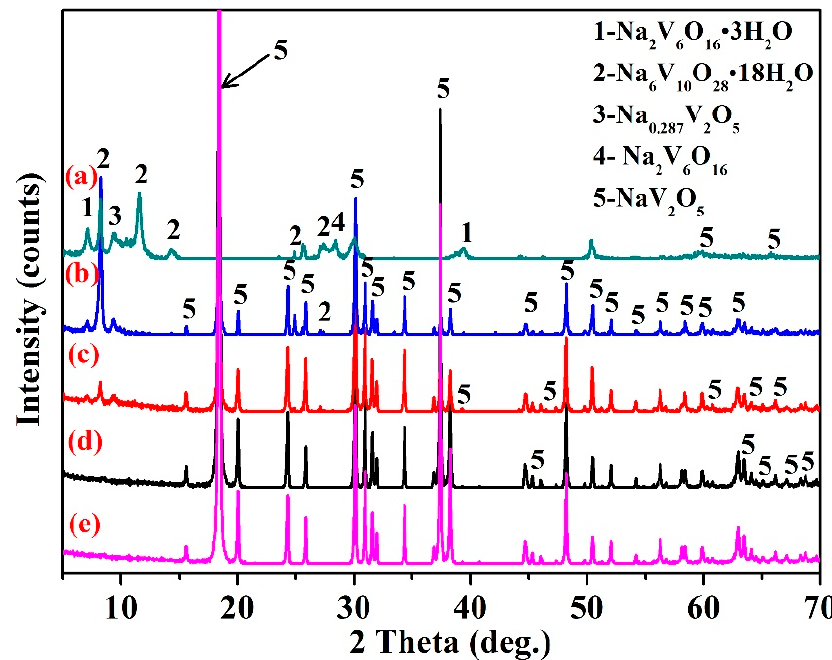
Figure 8. The phase compositions of the products obtained at ( a ) 1 MPa, ( b ) 2 MPa, ( c ) 3 MPa, ( d ) 4 MPa, and ( e ) 5 MPa under an initial solution pH value of 4, a reaction temperature of 200 °C, and a reaction time of 2 h.